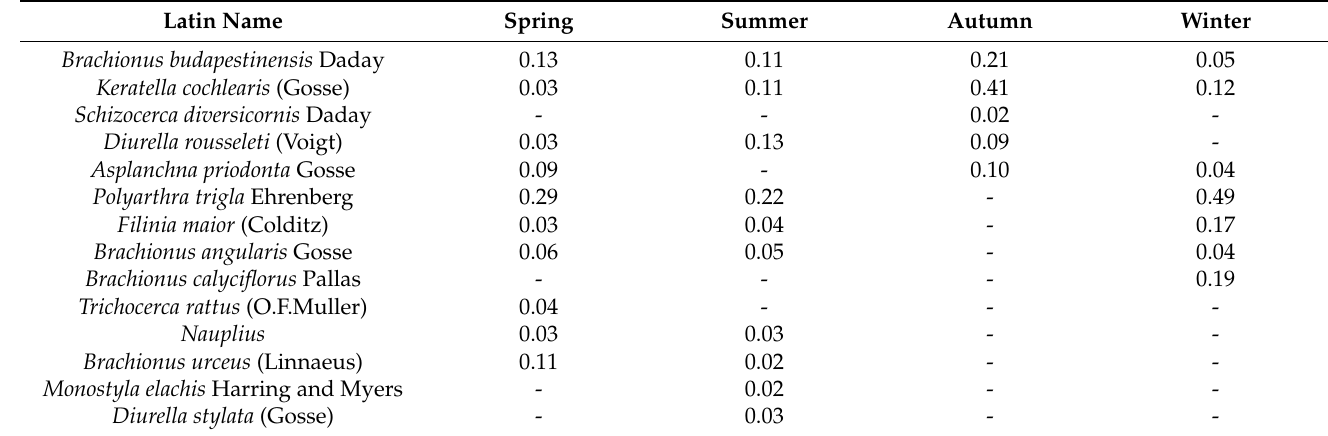
Table 2. Dominant species and dominance of zooplankton in Lake Chen Yao.